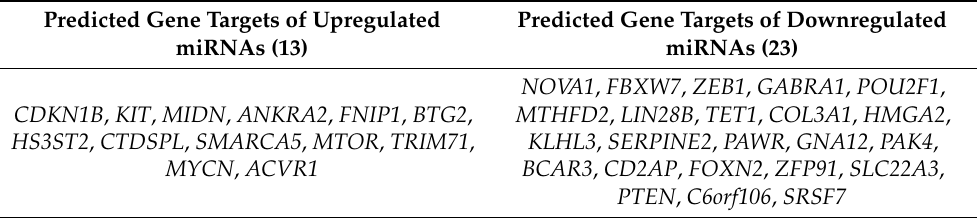
Table 1. List of commonly predicted gene targets of upregulated and downregulated miRNAs in BL cells exposed to HIV-1.